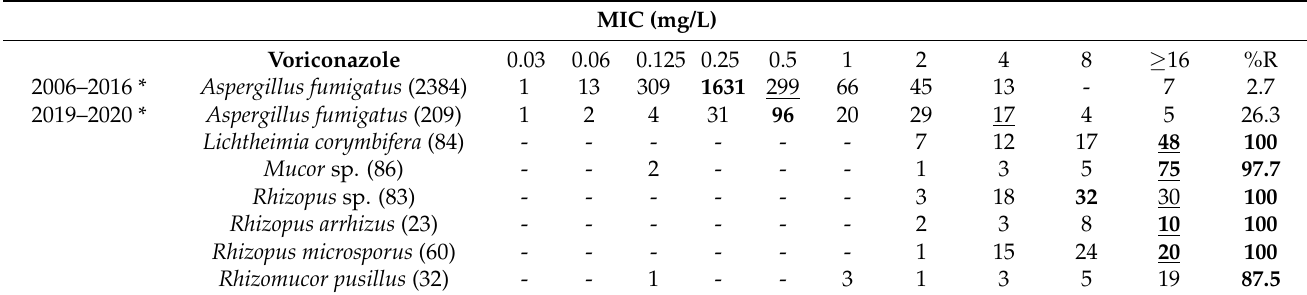
Table 4. MIC distributions for voriconazole. For presentation conventions, see Legend to Table 2.